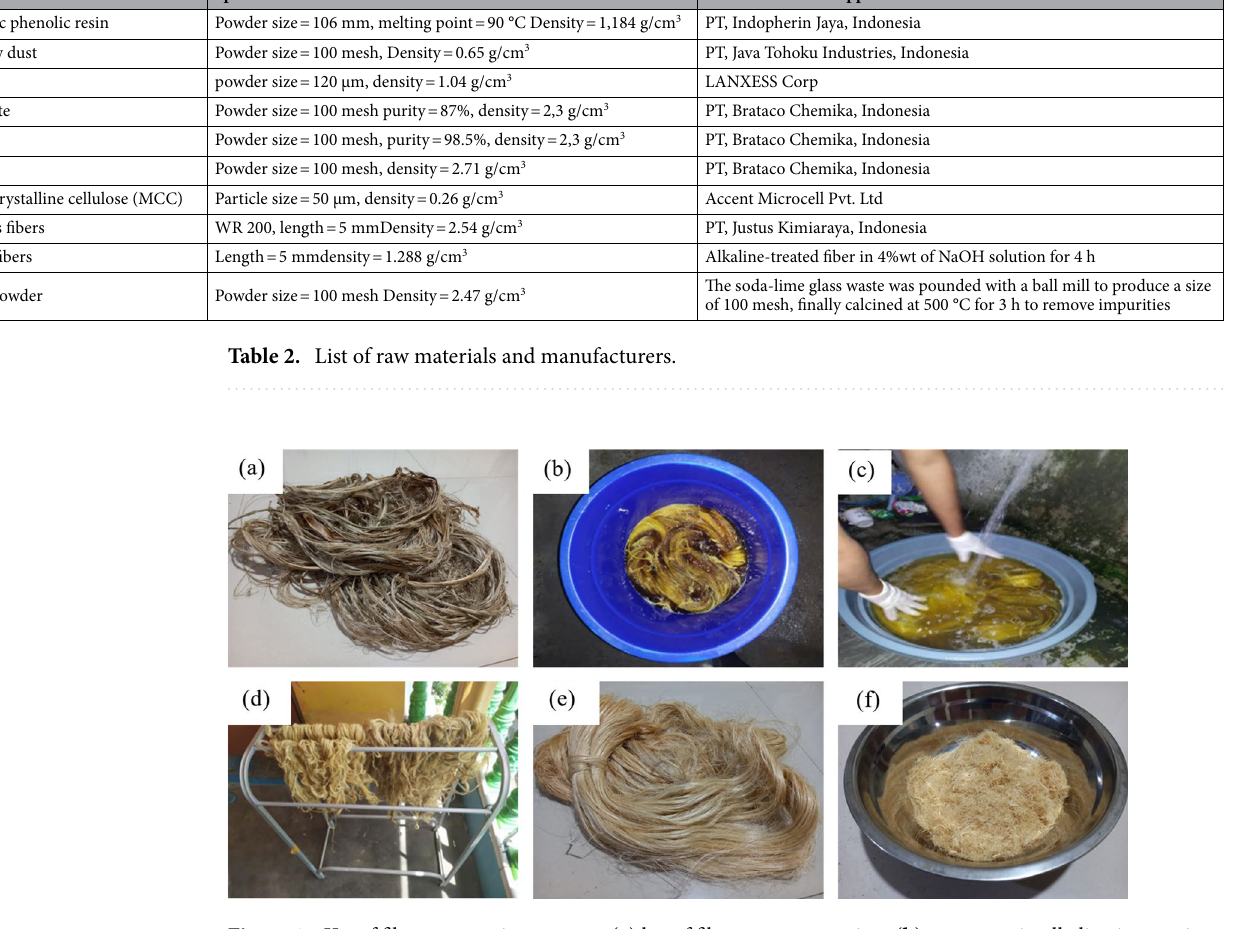
Figure 1. Kenaf fibre preparation process: ( a ) kenaf fibres post-extraction, ( b ) treatment in alkaline immersion, ( c ) pH neutralisation with an acetic acid solution and rinsing, ( d ) drying, and ( e ) cutting to short kenaf